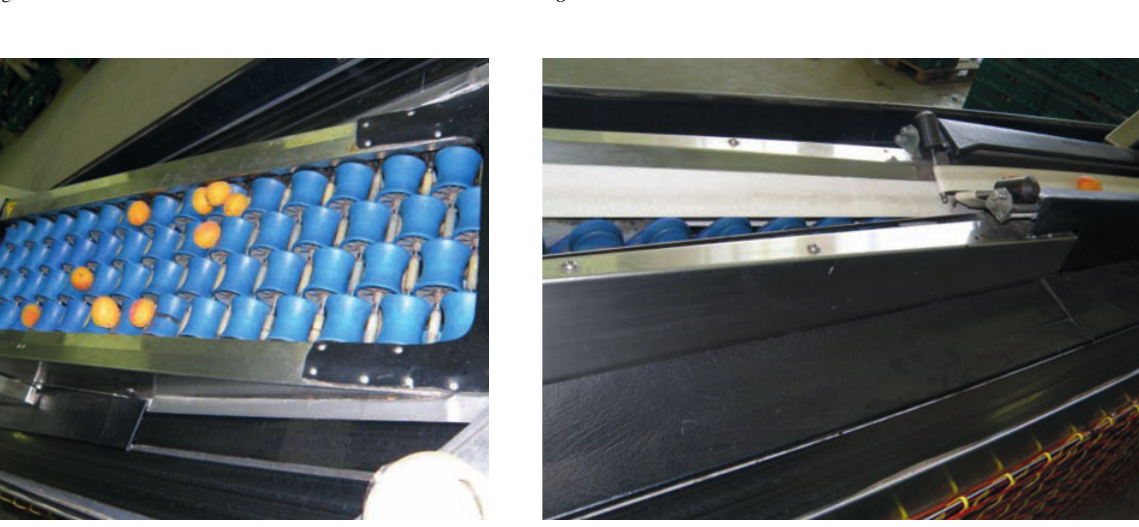
Fig. 1: Loading the machine Fig. 2: Manual selection